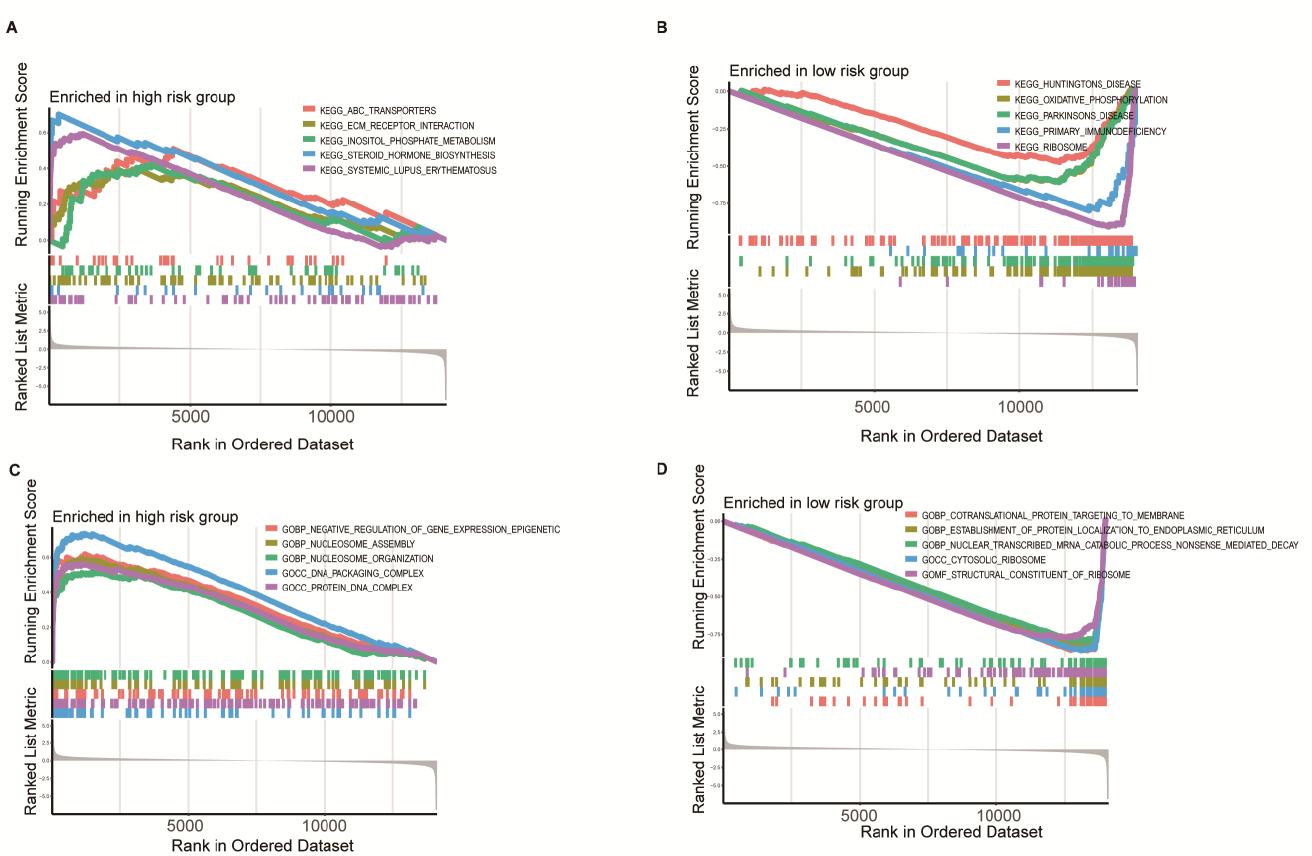
Figure 11. GSEA enrichment analysis was performed according to the risk score of ribosome-associated genes for the high-risk group and low-risk groups in TCGA BC cohorts. ( A , B ) KEGG enrichment in high and low risk groups. ( C , D ) GO enrichment in high and low risk groups.